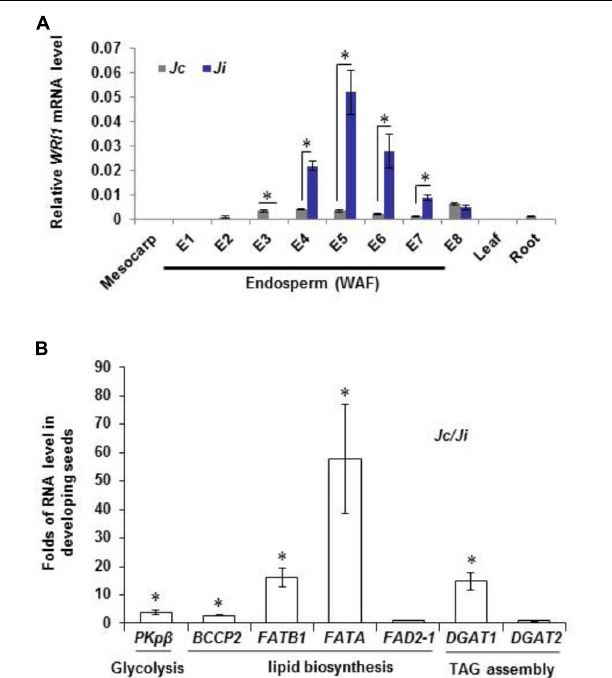
FIGURE 3 | Transcripts level of JcWRI1 and some key lipid-related genes in J. curcas and J. integerrima . (A) Expression levels of WRI1 in fruit mesocarp, leaf, root, and different endosperm developmental stages (from Endosperm 1 to Endosperm 8, E1–E8) of J. curcas ( Jc ) and J. integerrima ( Ji ). E1–E8 represented samples of endosperm at different developmental stages (1–8 weeks after fertilization, WAF). The Jatropha Ubiquitin transcript served as an internal control for all RNA samples. Values are mean ± SD ( n = 3) with statistical analysis by Student’s t -test ( ∗ indicates p < 0.05). (B) Comparison of expression levels of some key genes involved in glycolysis, lipid biosynthesis and TAG assembly in developing endosperms of J. curcas ( Jc ) and J. integerrima ( Ji ) at 6 WAF. The Jatropha Ubiquitin transcript served as an internal control for all RNA samples. The value was presented as fold of Jc to Ji . Values are mean ± SD ( n = 3) with statistical analysis by Student’s t -test ( ∗ indicates p < 0.05).